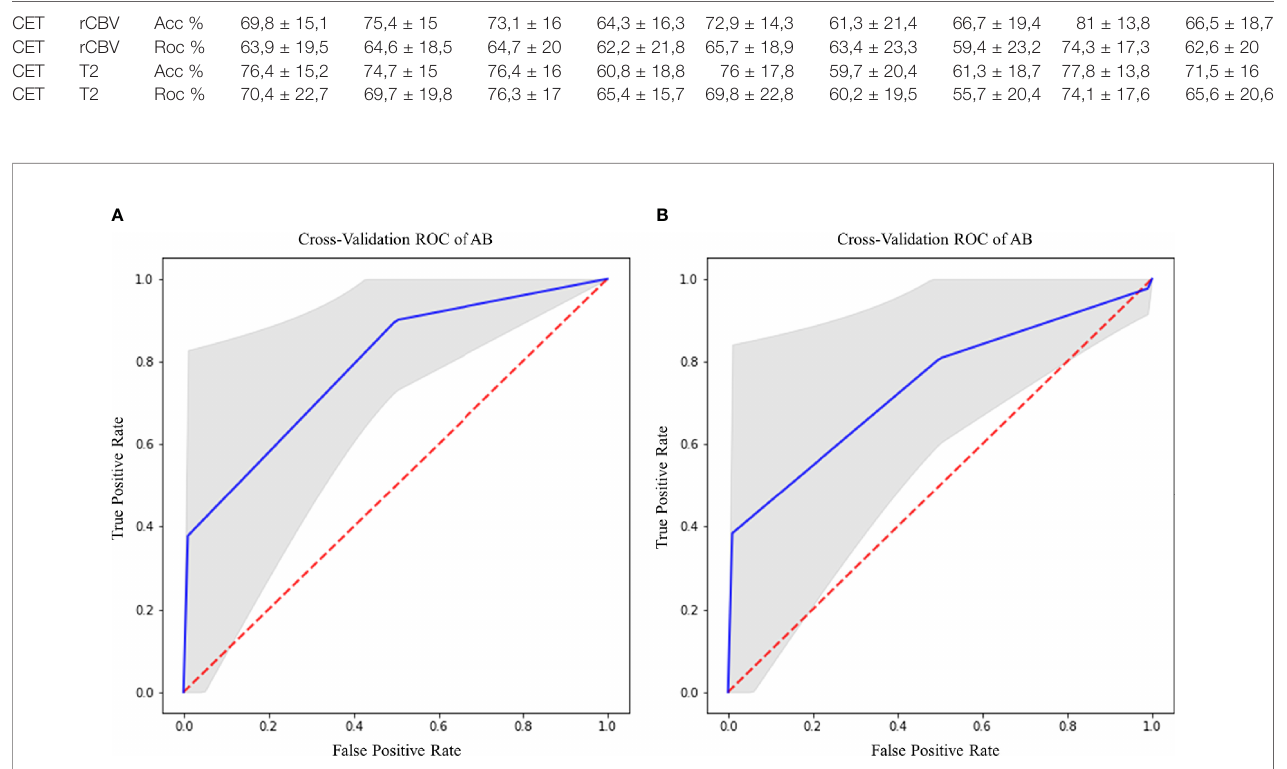
FIGURE 7 | Best ROC curves for EGFR prediction: (A) AB classi fi er with rCBV sequence on CET ROI; (B) AB classi fi er with T2 sequence on CET